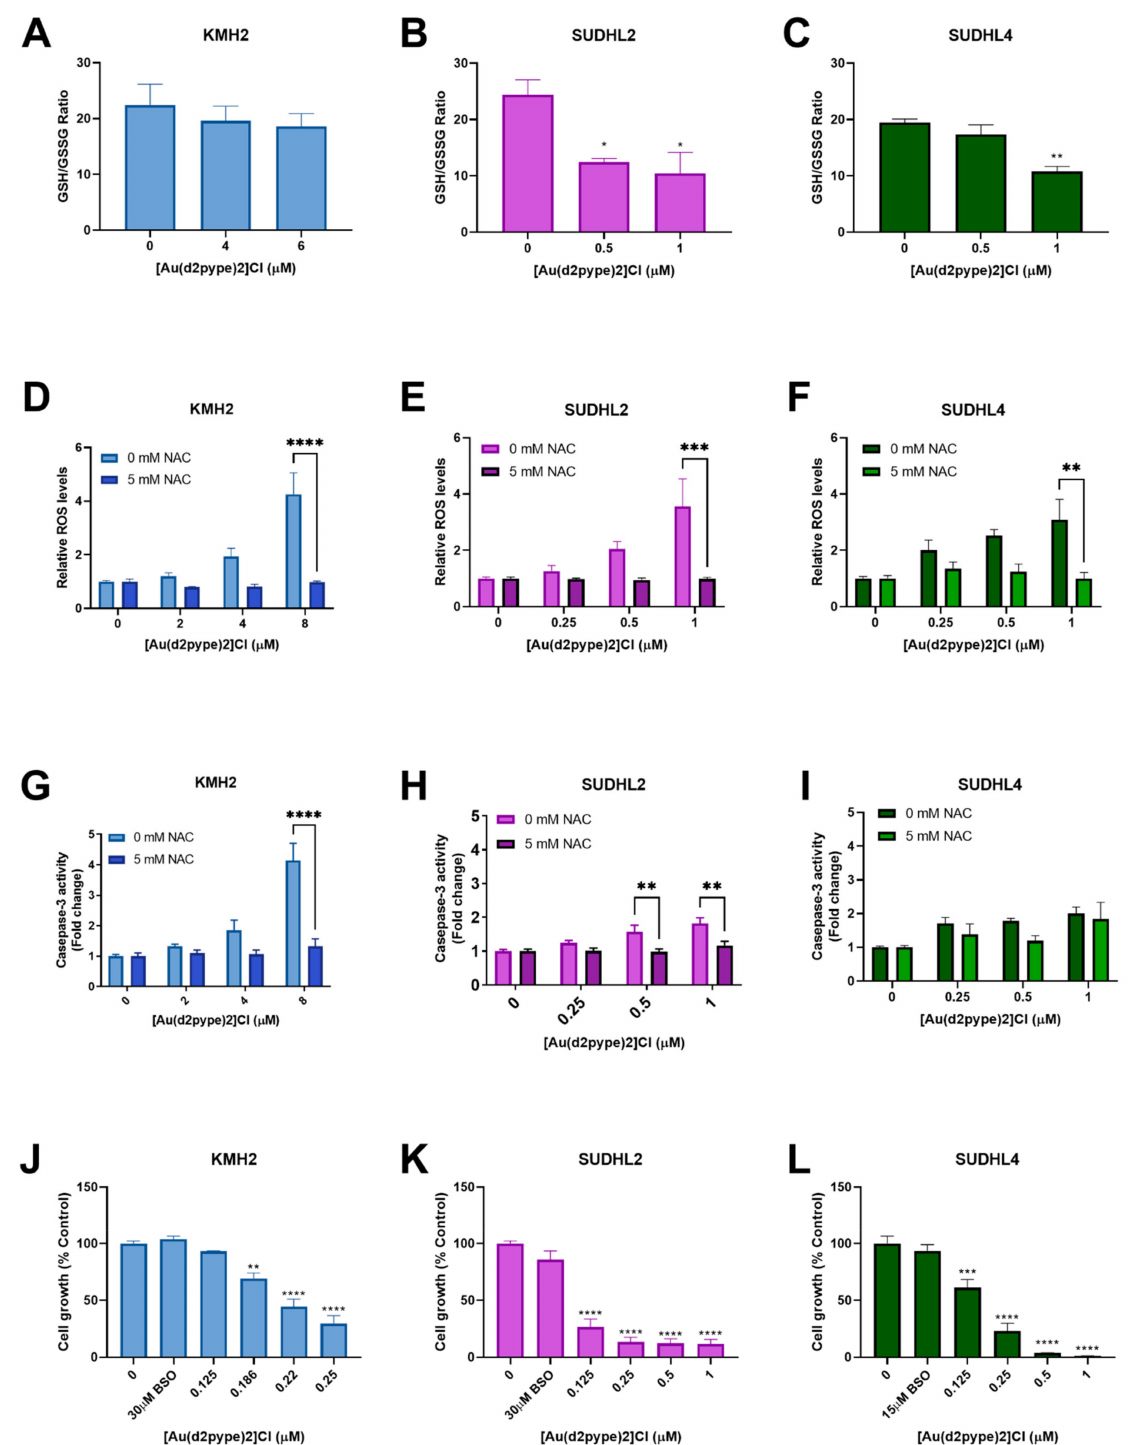
Figure 4. [Au(d2pype)2]Cl generates intracellular ROS and decreases the GSH/GSSG (reduced form of GSH/oxidized form of GSH) ratio in lymphoma cells. KMH2, SUDHL2, and SUDHL4 were treated with [Au(d2pype)2]Cl or co-treated with [Au(d2pype)2]Cl and NAC for 24 h. ( A – C ) GSH/GSSG ratio were measured using DTNB reduction. ( D – F ) ROS levels were measured using H 2 DCFDA oxidation. ( G – I ) Caspase-3 activity was measured using a fluorogenic assay. ( J – L ) Cell growth was detected by MTT assay. Results were analysed by one-way ANOVA using Dunnett’s post-test ( A – C , J – L ). Results were analysed by two-way ANOVA using Sidak’s multiple comparisons test ( D – I ). Values indicate mean ± SEM ( n = 3). * p < 0.05, ** p < 0.01, *** p < 0.001, **** p <0.0001, compared to untreated cells ( A – C , J – L ), or comparing 0 mM NAC to 5 mM NAC samples ( D – I